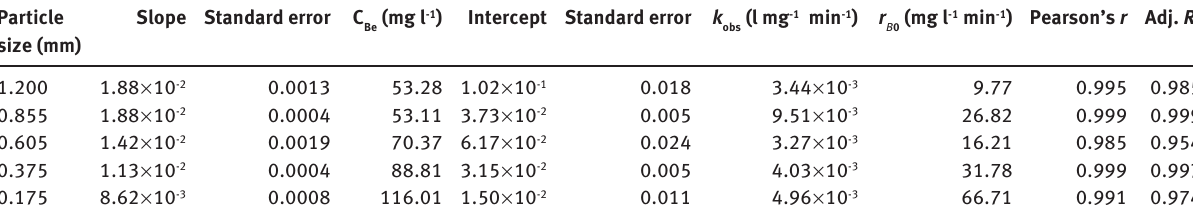
Table 5: Second-order kinetic model for the isothermal green solid-liquid extraction of andrographolide at 80 ° C from Andrographis panicu- lata (AP) for different particle sizes and solid-liquid ratio of 1:50 (g ml -1